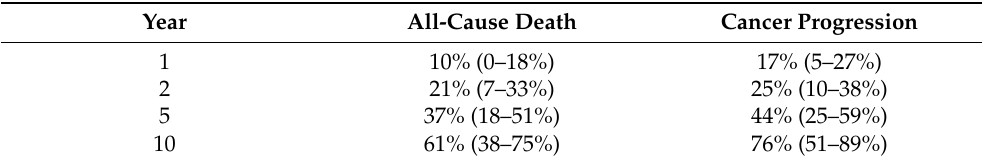
Table 8. The 1-, 2-, 5-, and 10-year cumulative incidence of all-cause death and cancer progression after salvage treatment of